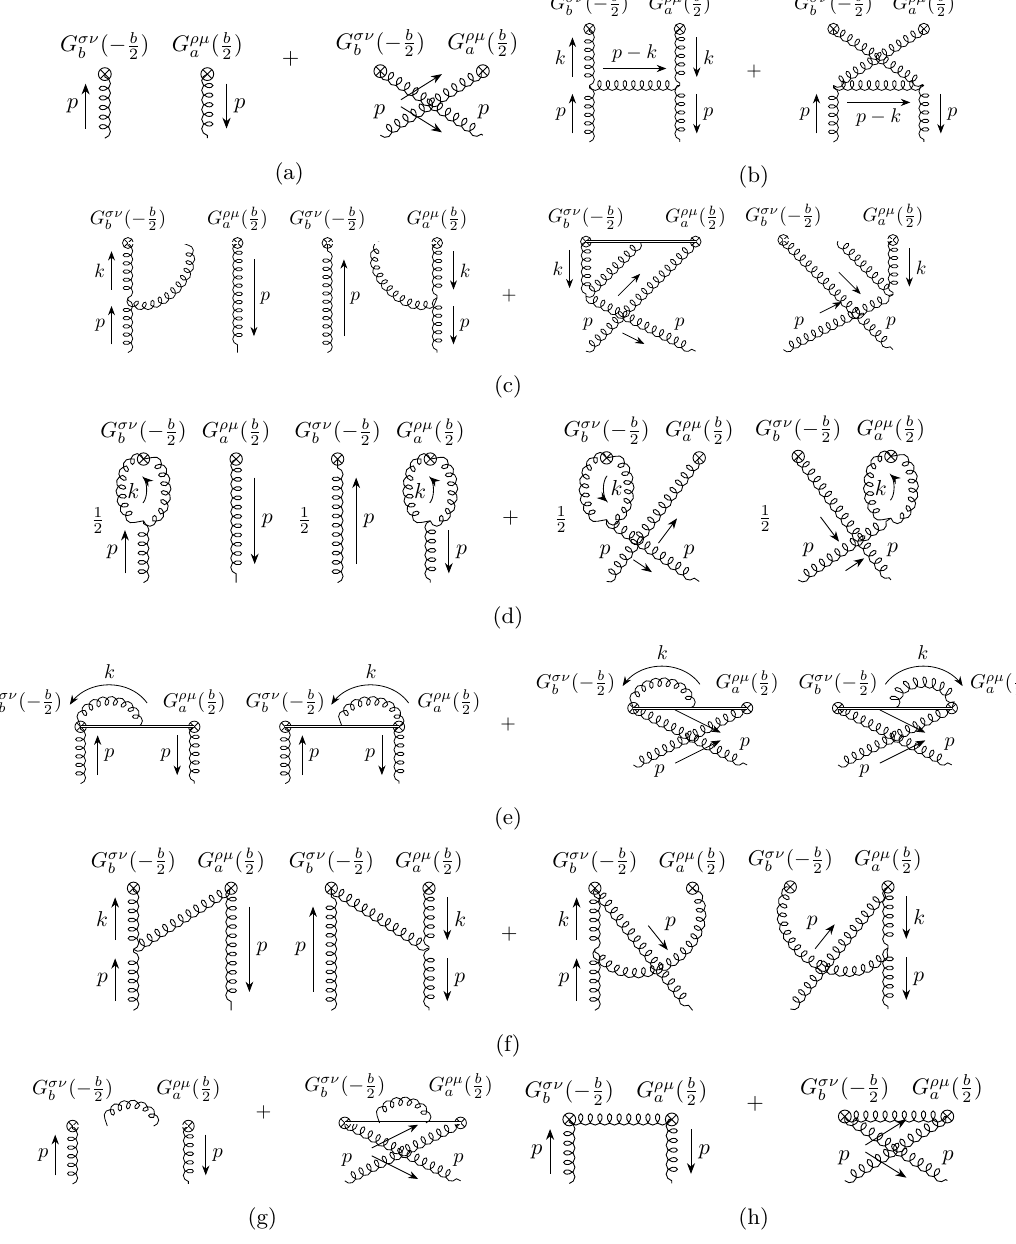
Figure 2. The tree-level (a) and one-loop level (b–h) diagrams contributing to gluon beam function in a free gluon state. Since the external gluons are transversely polarized, they cannot be attached to the Wilson lines in the n B direction. While depicted in these diagrams as a straight line, the beam function Wilson line actually traverses an infinitely long staple-shaped path, as shown in figure